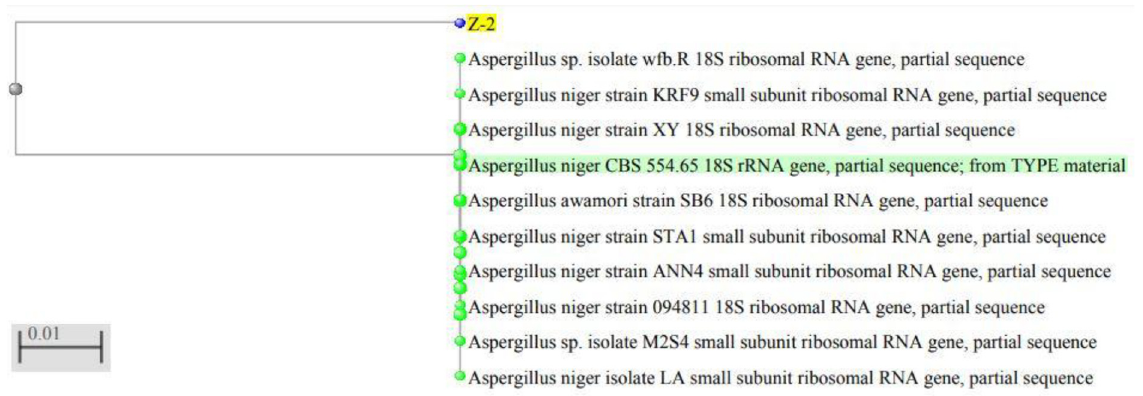
Figure 2. Phylogenetic tree showing interrelationship of our isolate with other strains of Aspergillus niger. Z-2 was the code used by us for the fungal isolate.